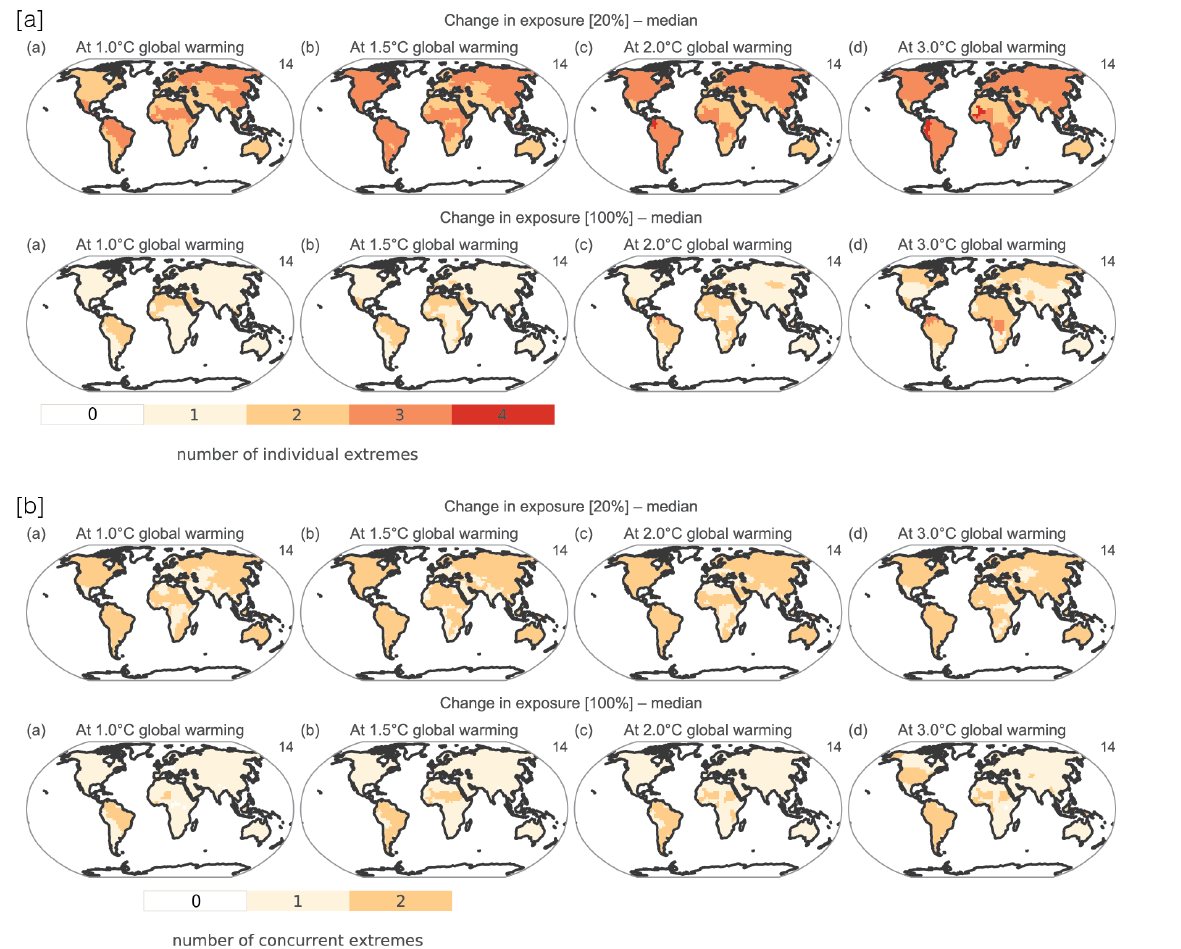
Figure 6. [a] Countries exposed to an increase in the event frequency for one, two, three or four individual extremes (heatwave, drought, Rx1day, wind) with relative increases over 20% (top row) and 100% (bottom row) with respect to the pre-industrial period. [b] Countries exposed to 1 or 2 concurrent extremes (heatwave–drought, Rx1day–wind) with relative increases over 20% (top row) and 100% (bottom row) with respect to the pre-industrial